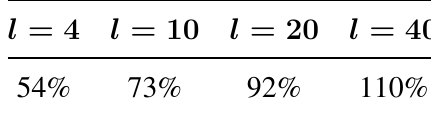
Table 3. Energy consumption of the proposed strategy expressed in % with respect to strategy #2.